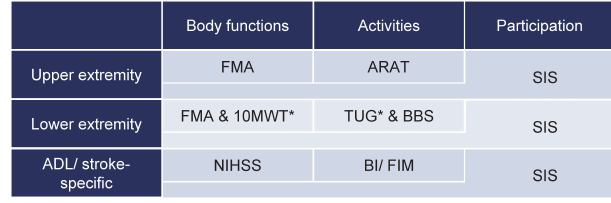
* Measure only required for patients with a Functional Ambulation Categories score of ≥ 3/5.